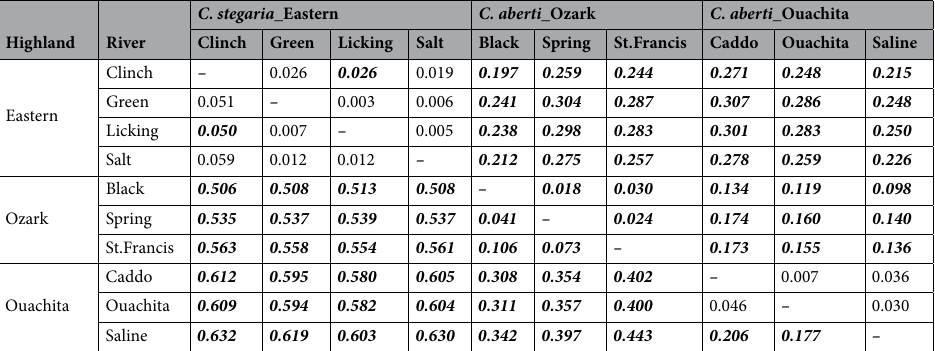
Table 2. Pairwise F ST ’s among 10 rivers throughout distribution range of genus Cyprogenia based on 7243 SNP loci. F ST values from raw data below diagonal and F ST values from corrected data above diagonal. A total of 146 individuals except two geographically isolated individuals (Ozark_105 and Ozark_107) were included in this analysis. Significance was tested by genic differentiation for each population pair from exact G test using default Markov chain parameters (Dememorisation: 10,000, Batches: 100, Iterations per batch: 5000). Bold Italicized indicates highly significant F ST value. Corrected data refers to data that missing data were replaced with randomly drawn alleles based on the overall allele frequencies. Significance level was adjusted for multiple testing using Bonferroni